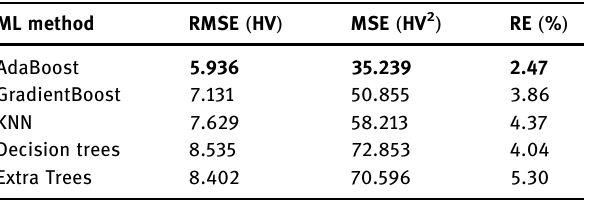
Table 3: Surface hardness prediction performance using di ff erent ML methods